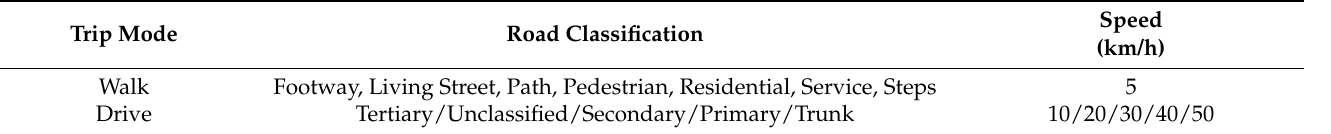
Table 1. Hierarchical road speed